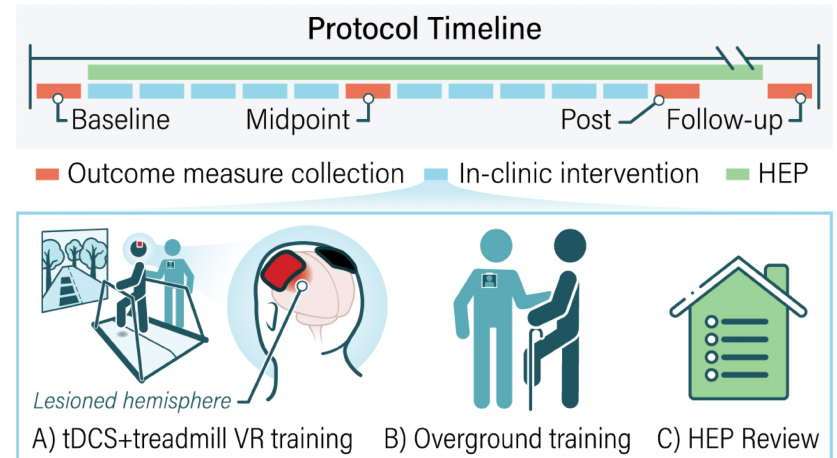
Figure 1. Gait training paradigm protocol. The protocol begins with baseline testing followed by 10 in-clinic intervention sessions. ( A ) During the in-clinic sessions, users practice weight shifting and targeted stance phase training using treadmill in a VR environment while stimulated by tDCS. ( B ) During the second portion of each training session, they perform task-oriented overground gait training. ( C ) At the end of the in-clinic sessions users review their personalized home exercise program (HEP). Users are asked to practice HEP independently in a safe environment at home. The users underwent testing after session 5 (midpoint), session 10 (post testing), and 3-week follow-up. users are asked to practice HEP independently during the follow-up